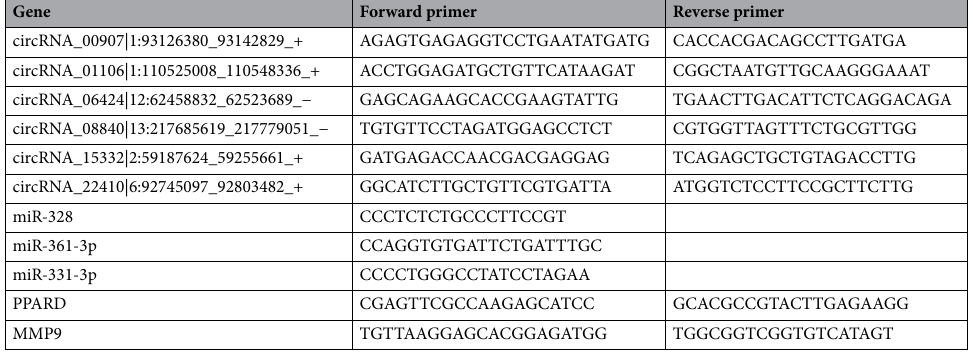
Table 1. Gene and the corresponding primer